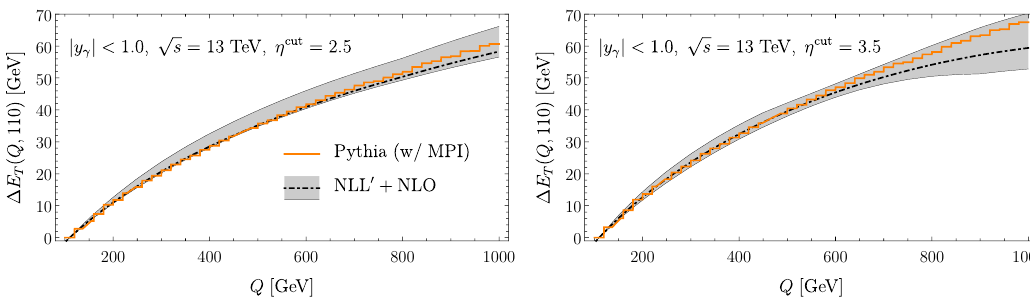
Figure 3 . The observabel (cid:1) E ( Q; Q ) for Q = 110 GeV for two di(cid:11)erent values of the rapidity T 0 0 cuto(cid:11) parameter (cid:17) = 2 : 5 (left) and (cid:17) = 3 : 5 (right). cut cut transverse energy. The di(cid:11)erence of higher moments includes MPI contributions that can be used to determine parameters of MPI